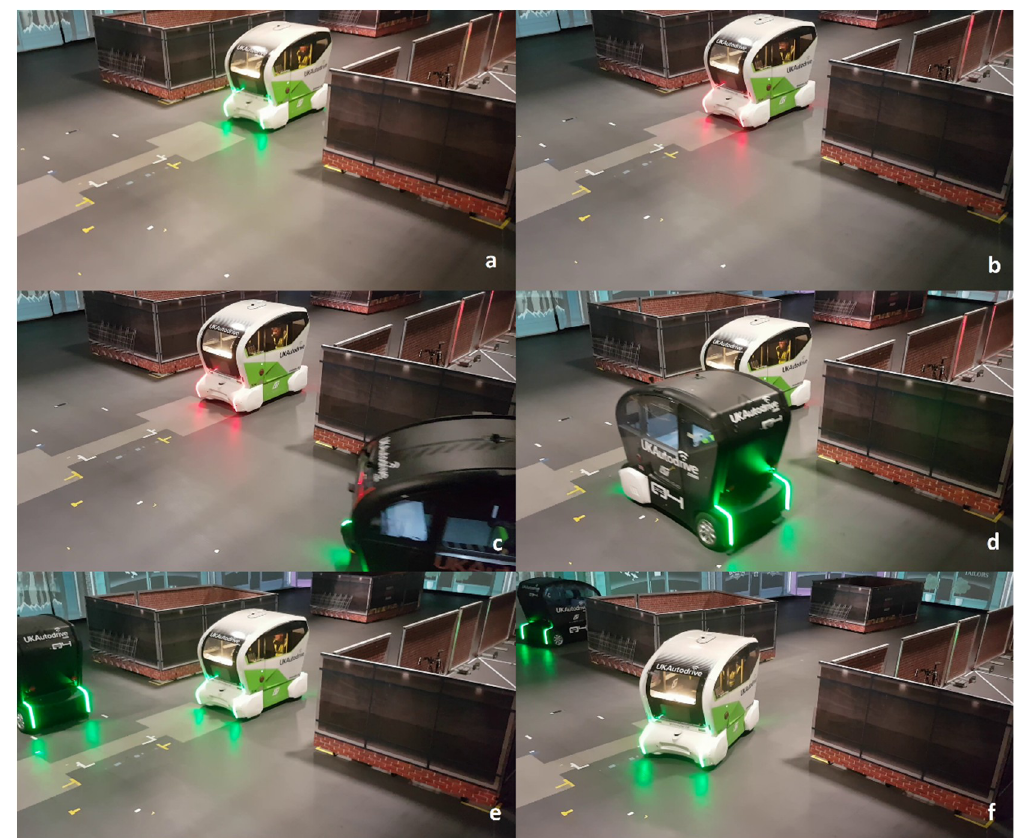
Figure 3. Vehicles negotiating the T-junction during the machine-like experiment. The white vehicle ( a ) arrives at the junction, ( b ) stops and applies the brakes (as indicated by the red LEDs around the wheel wings) as it ‘knows’ the black vehicle is approaching. The black vehicle turns the corner ( c ) and passes in front of the white vehicle ( d ), which then disengages the brakes ( e ) and is clear to proceed ( f ).